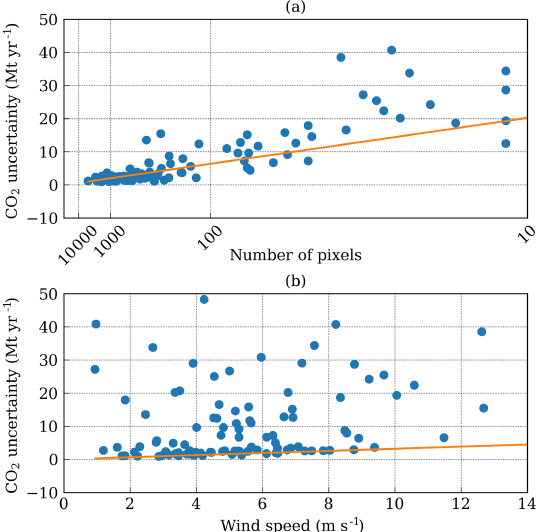
Figure 3. Dependency of the theoretical CO 2 uncertainty on (a) in- verse of the square root of the number of pixels and (b) wind speed. The line is the fit of a multilinear regression model that was used to determine the slope of the linear dependence on these